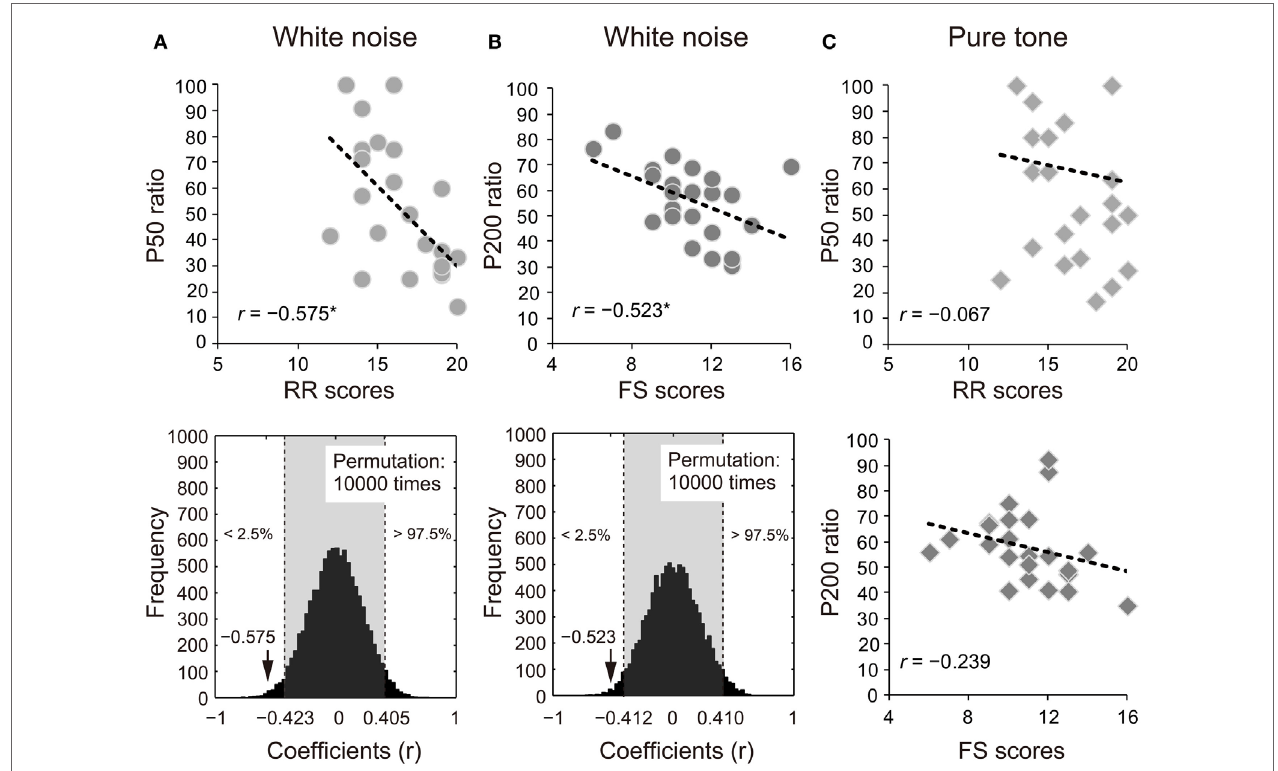
FigUre 3 | Proportional scores (stimulus2/stimulus1 × 100) of (a) P50 and (B) P200 for white noise negatively correlate with self-reported reward responsiveness (rr) and fun-seeking (Fs), respectively (upper diagrams) . The actual coefficients (P50: r = − 0.575; P200: r = − 0.523) are outside 95% confidence intervals (light gray areas) obtained by permutation correlation analyses (lower diagrams). (c) P50 and P200 ratios for pure tones correlated with self-reported RR and FS, respectively for ease of